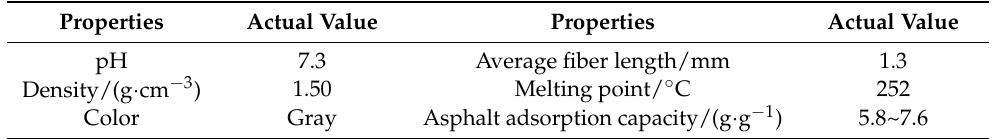
Table 5. Physical properties of lignin